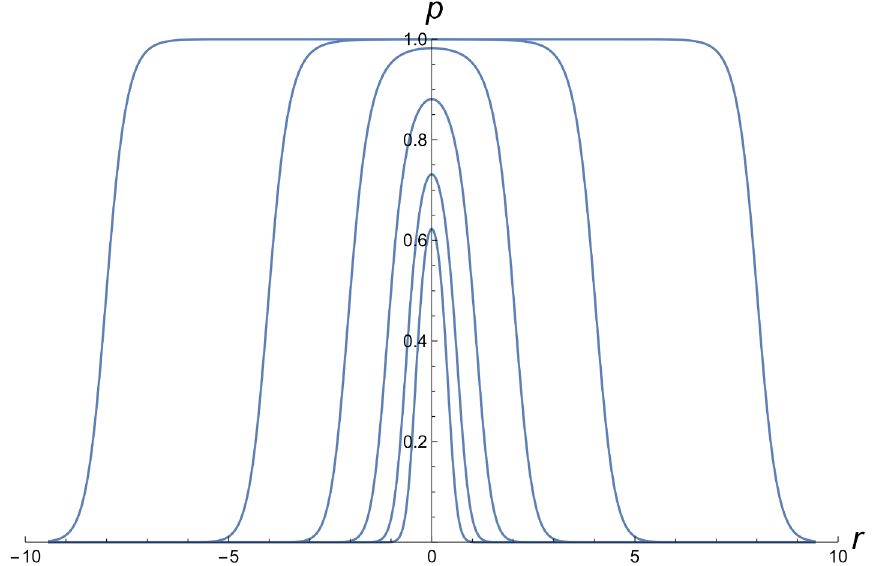
Fig 8. The statistical Model (7) describing the position and width of the wave. Assuming wave width w = 1, the figure illustrates the transition from a near-Gaussian distributionof infection frequencies near the centre of the release (for r 0 = 0.25, 0.5) to a wave traveling in both directions(for r 0 = 1, 2, 4,